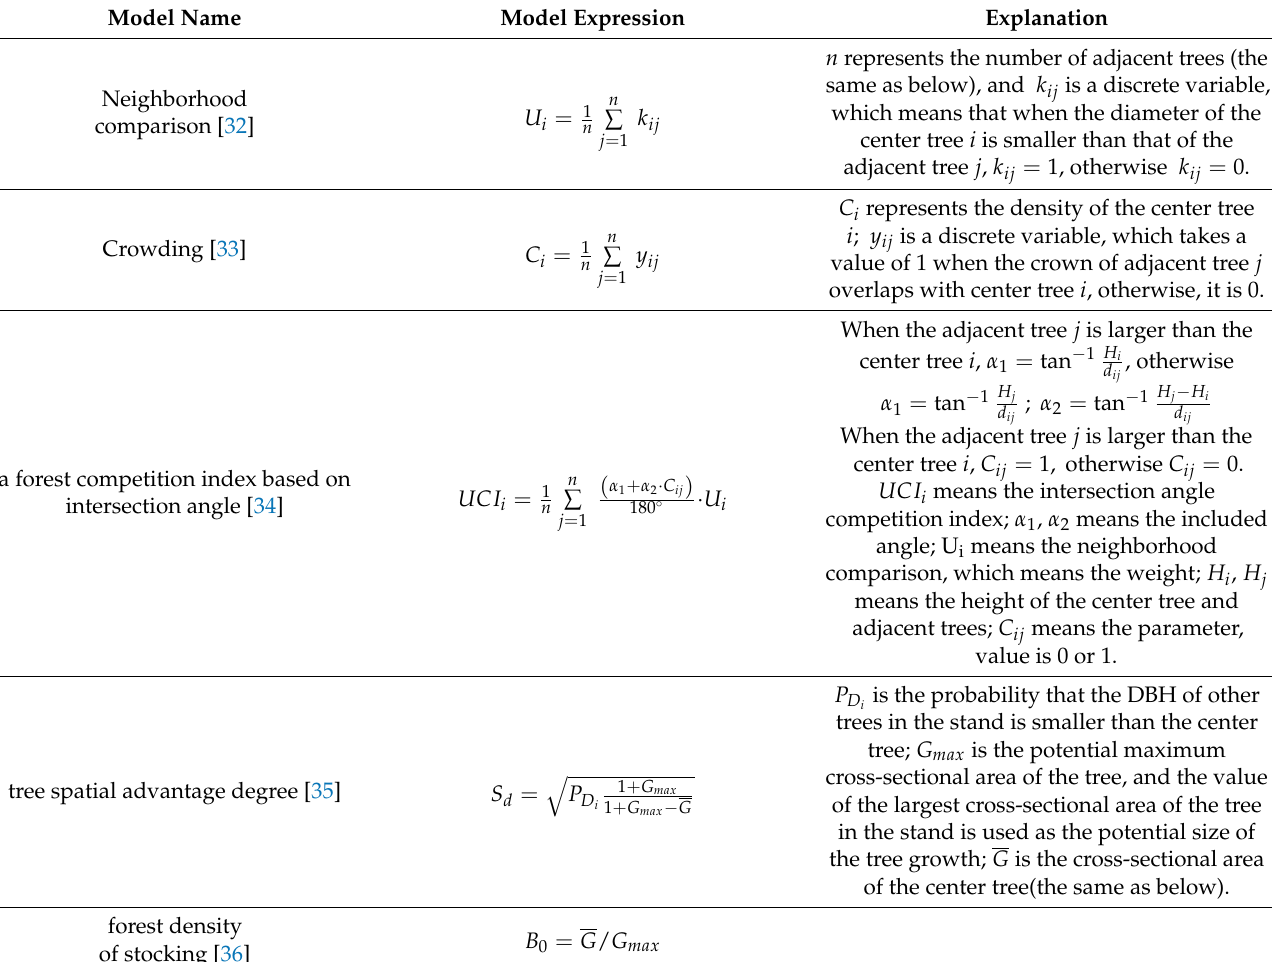
Table 2. Calculation parameters of the comprehensive grade of Chinese fir spatial